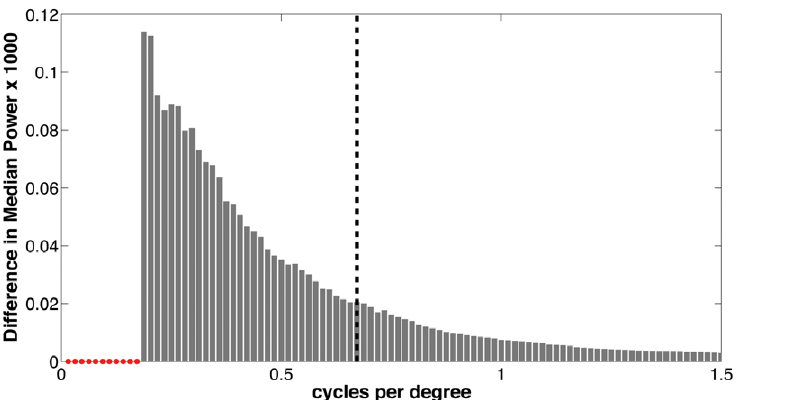
Figure 5. The effects of low-pass filtering on spectral power. Power spectra in 800 frequency bins were computed for the unfiltered images used in Experiment 2, and compared to power spectra of the Gaussian filtered images used in Experiment 3. The median difference in power per bin is plotted. This shows that seventy-five percent of the difference is accounted for in frequency bins between 0.2 and 0.67 cycles per degree (left of vertical dashed line). The power does not differ significantly in the range 0 to 0.19 cycles per degree (small red circles).